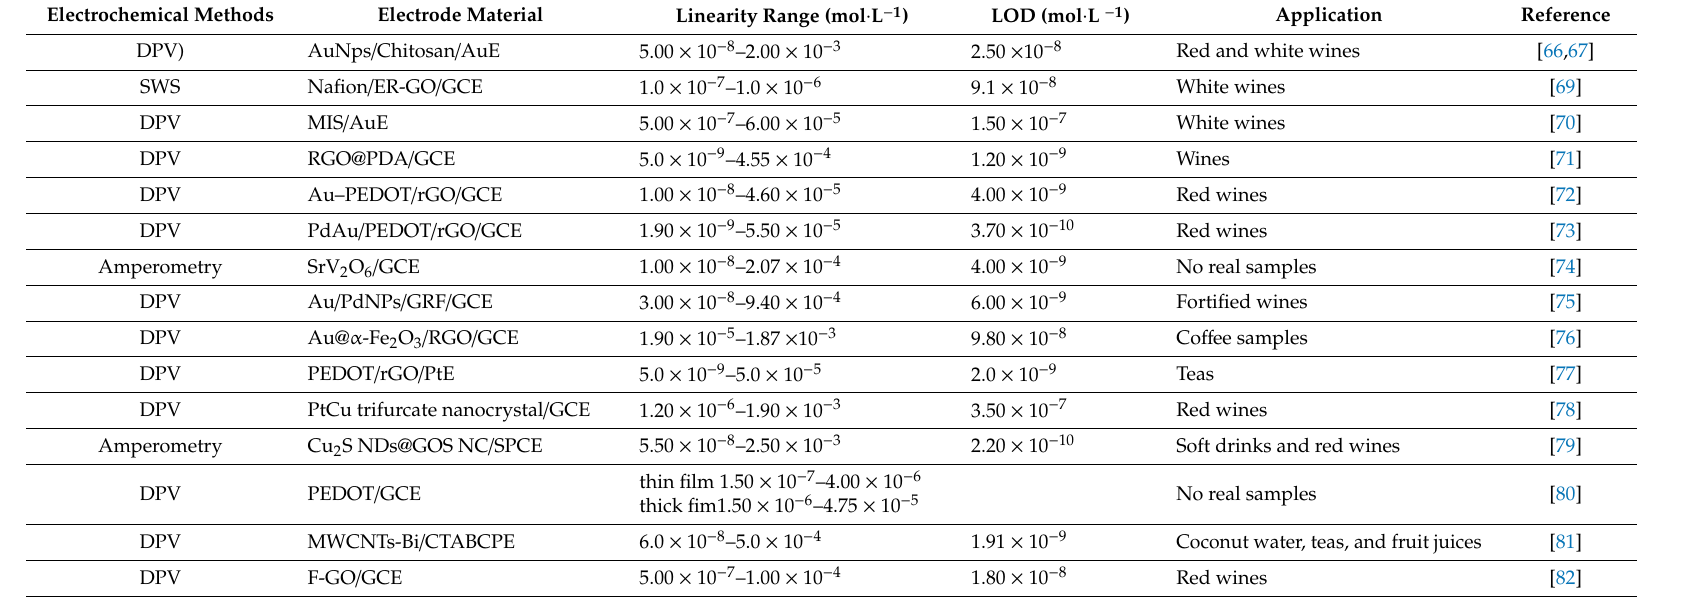
Table 1. An overview of recent electrochemical sensors for CA determination, using nanomaterials and / or nanocomposites. Electrochemical